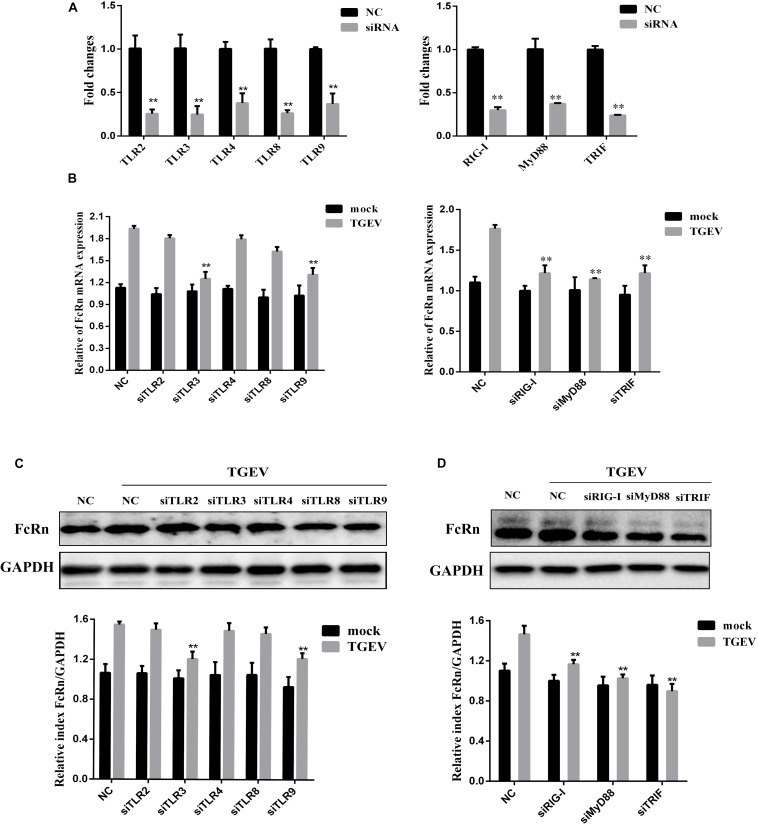
Involvement of TLR signaling cascades in FcRn activation by TGEV. (A) IPEC-J2 cells were transfected with 50 nM specific siRNAs targeting TLR2/3/4/8/9, TRIF, MyD88, RIG-I or NC siRNA, respectively for 24 h, then cells were collected for analysis of mRNA levels using RT-qPCR assays. (B) IPEC-J2 cells were transfected with the siRNAs TLR2/3/4/8/9, TRIF, MyD88, RIG-I or NC siRNA, respectively for 24 h, then with/without TGEV infection (MOI = 1). At 24 hpi, total RNA was extracted and FcRn or GAPDH mRNA expression was analyzed by RT-qPCR. (C,D) IPEC-J2 cells were transfected with the siRNAs TLR2/3/4/8/9, TRIF, MyD88, RIG-I or NC siRNA, respectively for 24 h, then with/without TGEV infection (MOI 1). IPEC-J2 cells were harvested at 36 hpi and measured by Western blot. The right panel represents the quantification of the bands by densitometry, corrected by the amount of GAPDH. ∗∗p < 0.01.